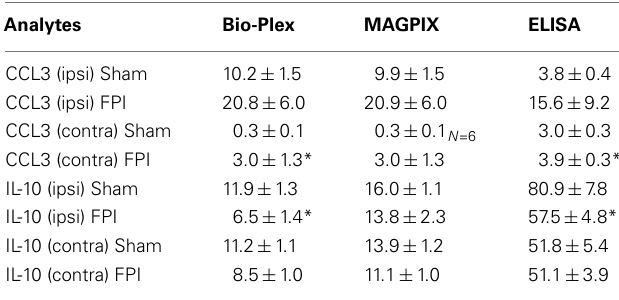
Table 4 | Effects of FPI on the cortical levels of IL-10 and CCL3 as detected by Bio-Plex, MAGPIX, and traditional ELISA 24h after